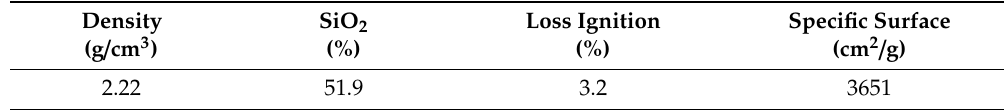
Table 4. Properties of fly ash.